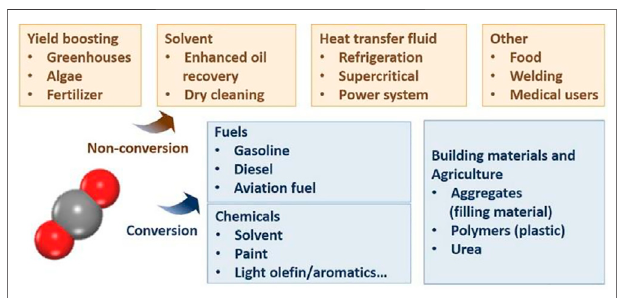
FIGURE 3 | Simple classi fi cation of CO 2 utilization pathways.